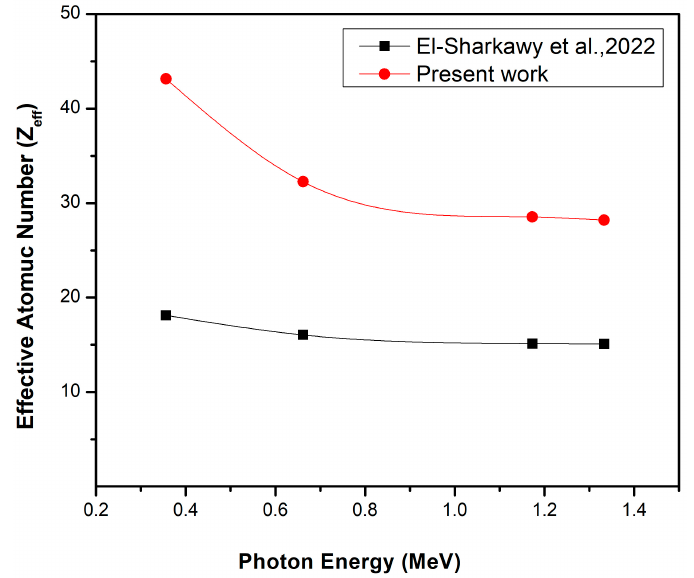
Figure 10. The effective atomic number of the present work (red line) and the effective atomic num- ber of El-Sharkawy et al. (back line) [31], for the same 20 wt% Bi 2 O 3 NPs.